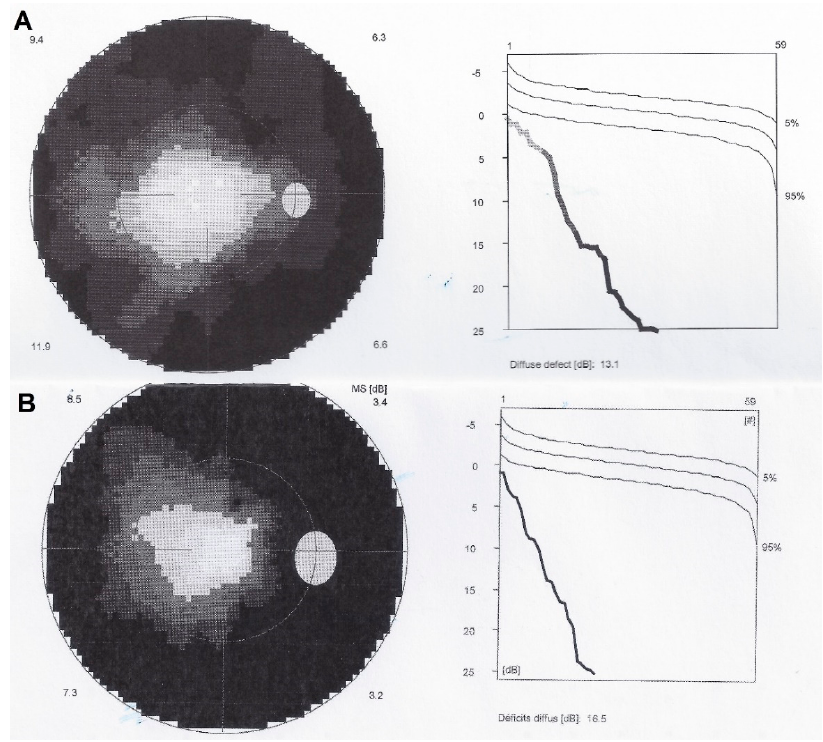
Figure 3. Visual fields OD in AZOOR patient 1. Shows tubular visual field at presentation ( A ) and increase of annular scotoma after 6 years of follow-up ( B ).